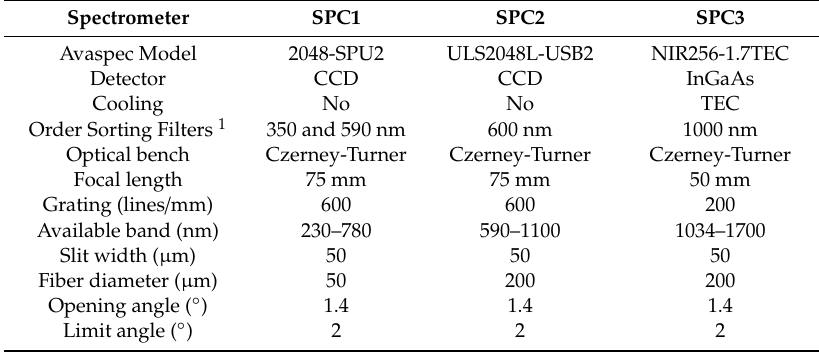
Table 1. Specifications of the spectrometers and characteristics of the